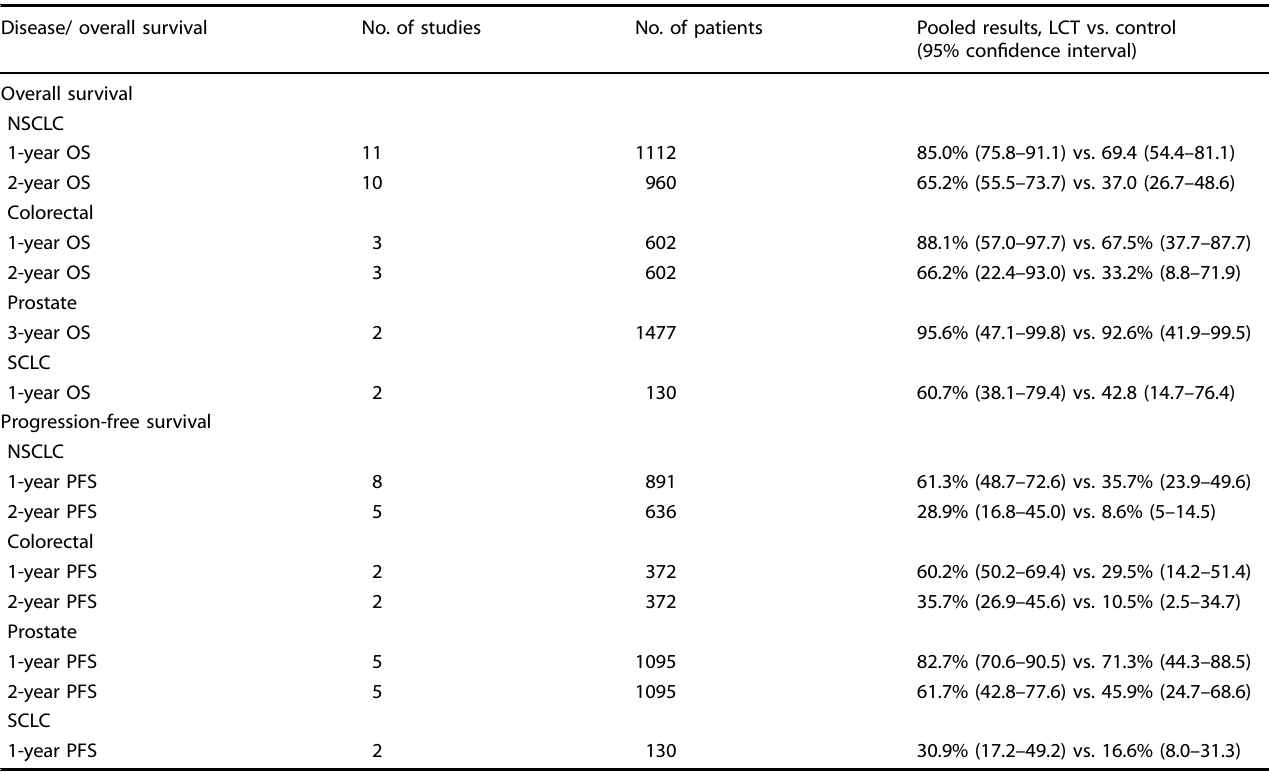
Table 4. Pooled temporal analyses of numerical overall and progression-free survival. Disease/ overall